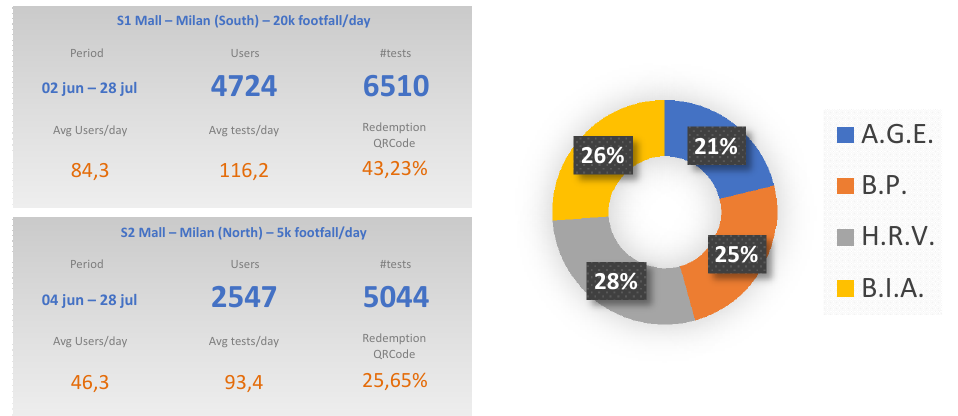
Figure 3. Statistics of health pod pilot tests in malls with 20,000+ visitors per day (S1) and 5000+ visitors per day (S2) and total test distribution at the two sites ( right ): A.G.E., advanced glycation end products; B.P., blood pressure; H.R.V., heart rate variability; B.I.A., body impedance analysis.